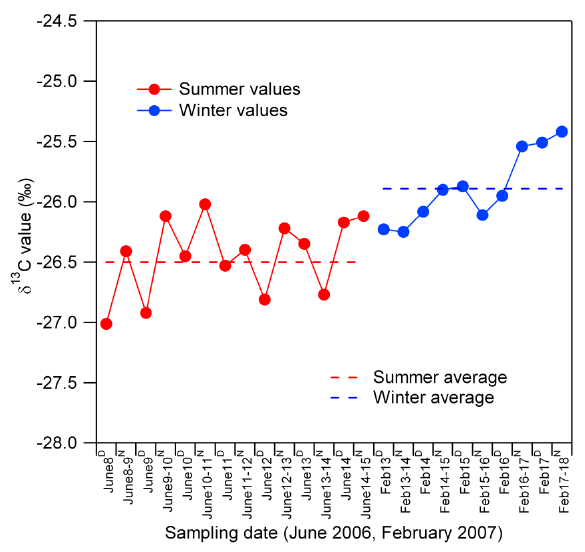
Fig. 9. Temporal variations in δ 13 C values of